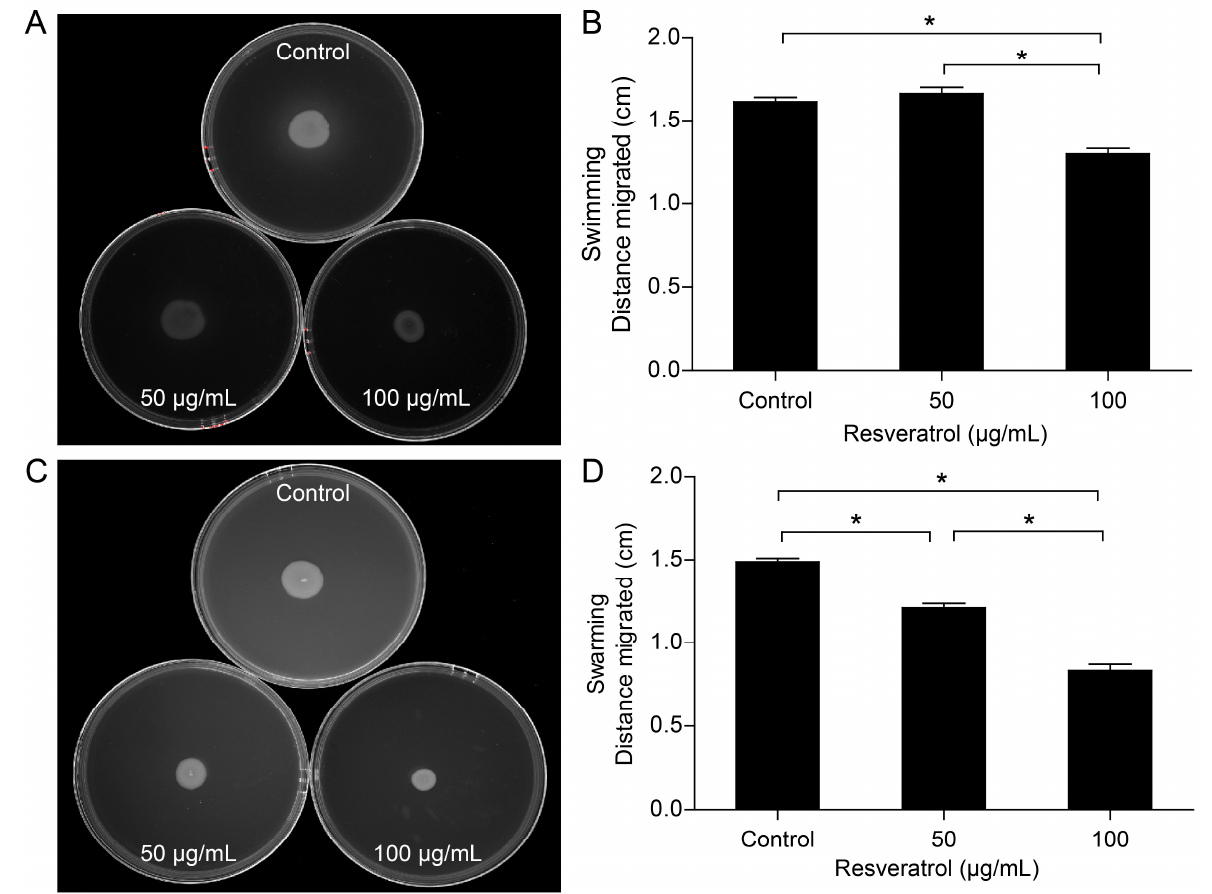
Figure 3. Effects of resveratrol on the swimming and swarming motility of A. hydrophila . The abilities of swimming ( A , B ) and swarming ( C , D ) motility were assessed by examining the migration of bacteria through the agar, from the center toward the periphery of the plate. The results were reproduced in three independent experiments, and the error bars represent SDs. * p < 0.05.